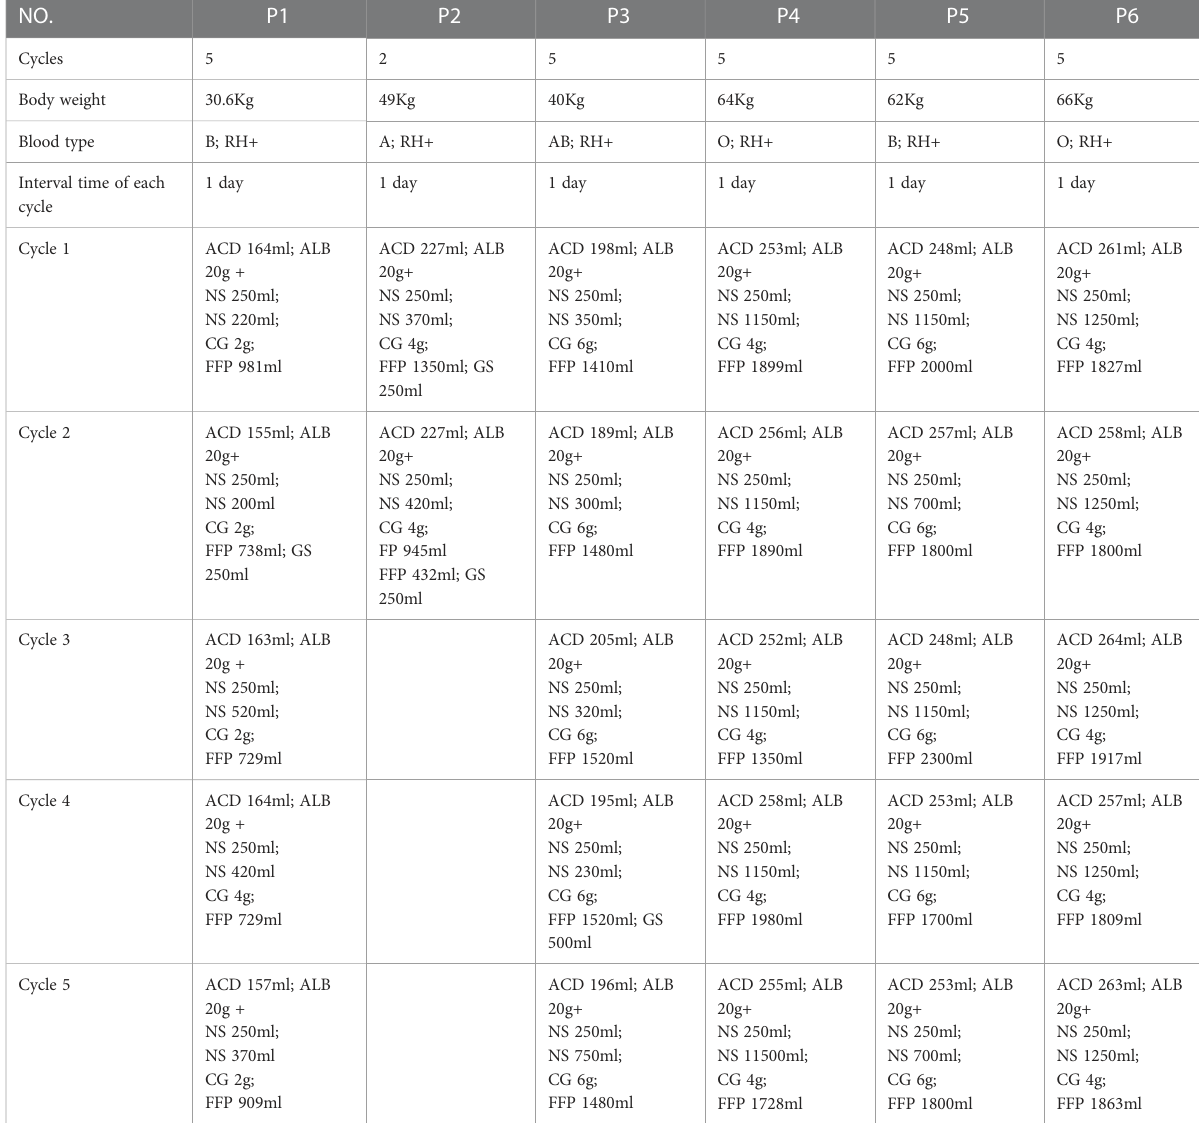
TABLE 1 PE procedure of patients with